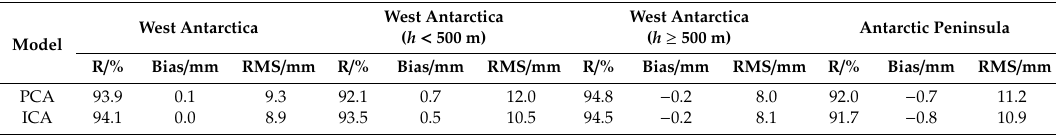
Table 2. Correlation coe ffi cient R, bias, and RMS between the ZTD models and GPS-ZTD of nonmodeling